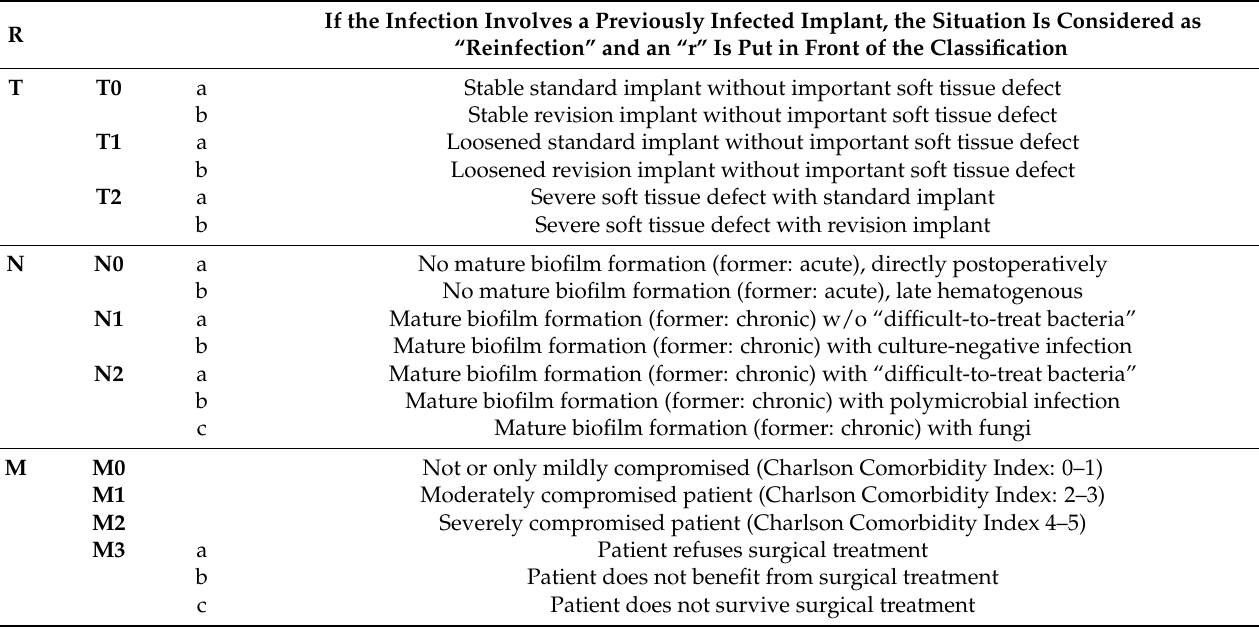
Table 1. The original PJI-TNM classification as introduced by Alt et al. in 2020.